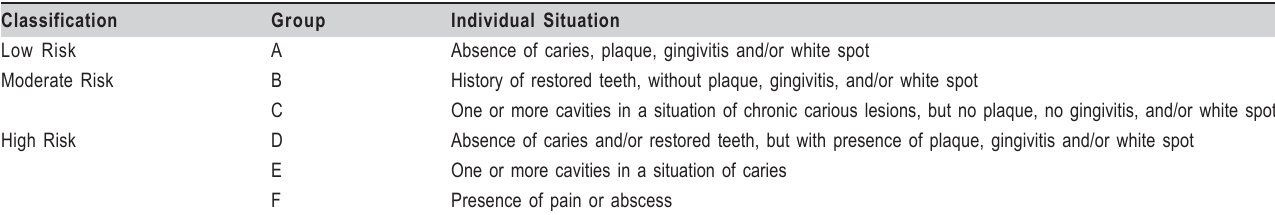
Table 1. Table used as a reference for the classification of individuals according to the risk of caries.